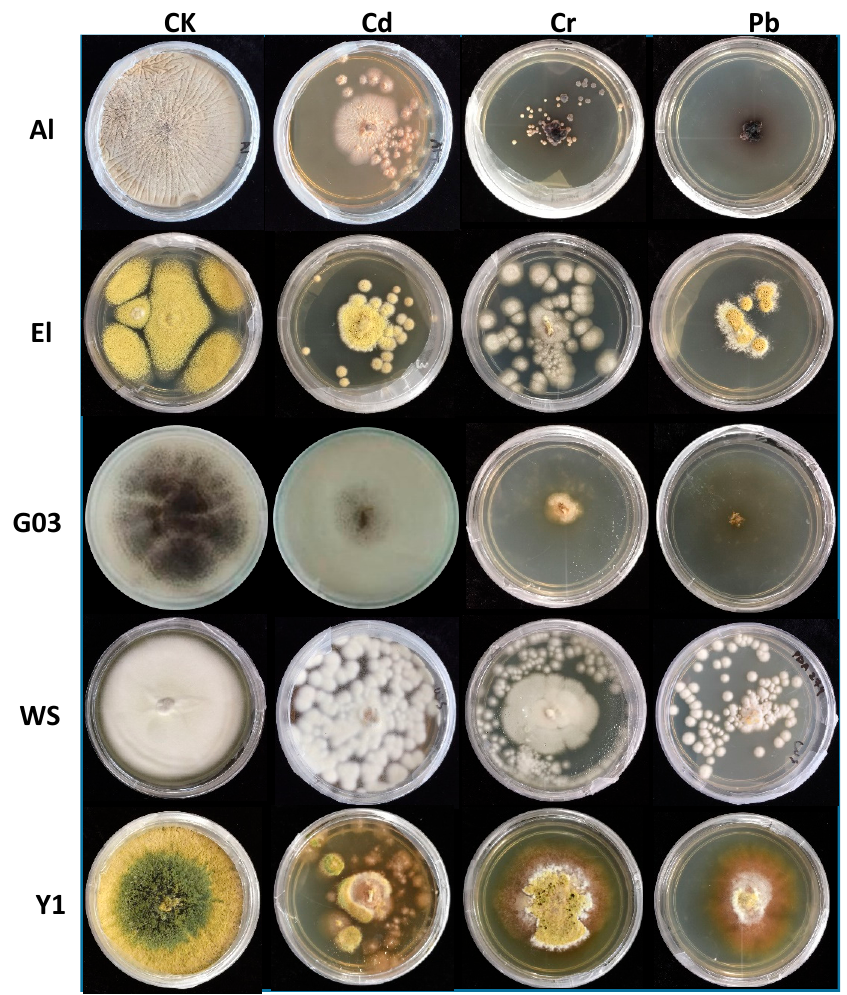
Figure 3. Growth of fungi on media supplemented with 1500 ppm concentration of Cd, Cr, and Pb. Five isolates including Aspergillus sclerotiorum (A1), Aspergillus aculeatus (E1), Aspergillus niger (G03), Komagataella phaffi (WS), and Trichoderma harzianum (Y1) were grown on control media (CK), cadmium supplements media (Cd), chromium supplemented media (Cr), and lead supplemented media (Pb). The growth of Aspergillus sclerotiorum (A1) and Aspergillus niger (G03) was observed to be severely retarded in Pb amended media.